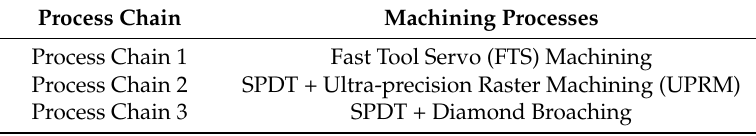
Table 1. Different machining process chains for manufacturing polar microstructure.